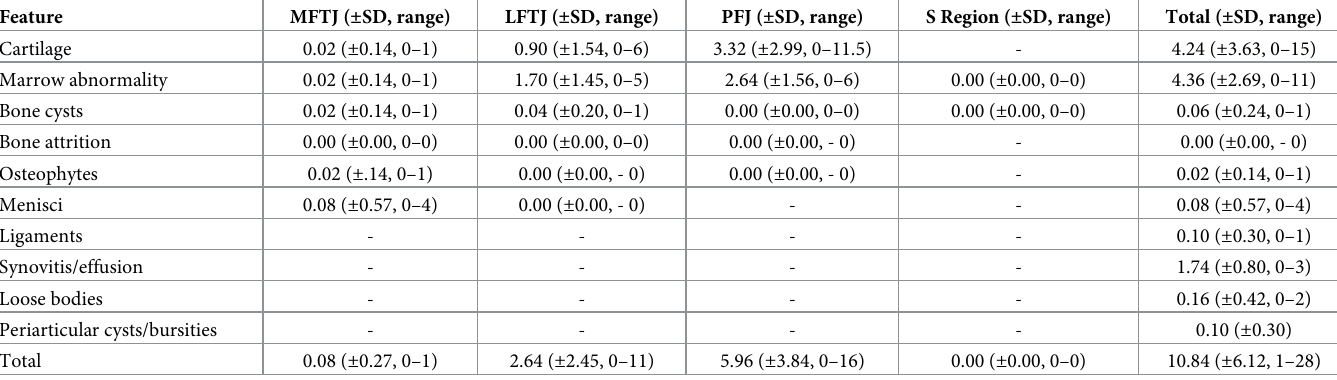
Table 3. Average WORMS of separate regions and in